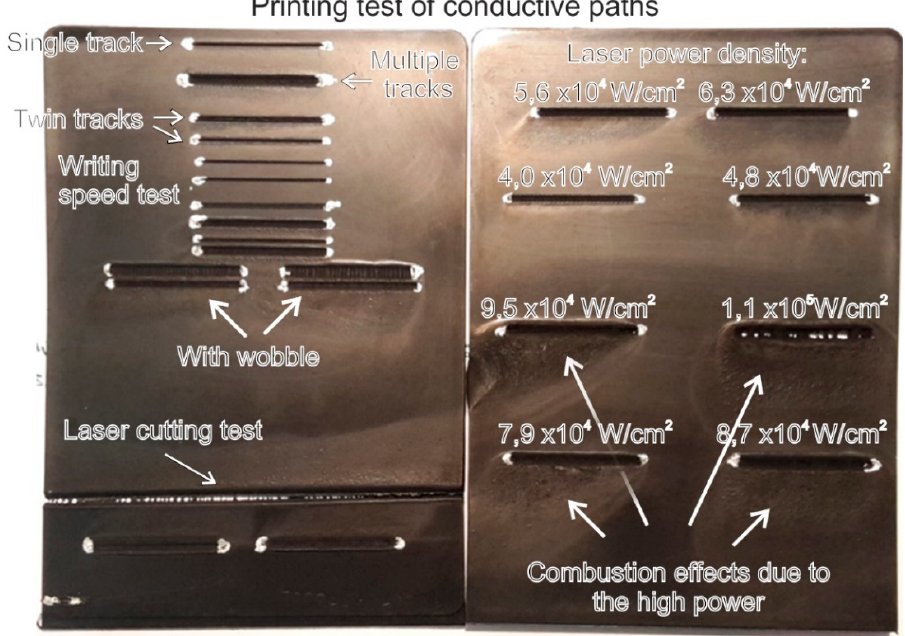
Figure 4. Effect of the laser processing parameters (power density, frequency, speed, repetition cycle, wobbler).